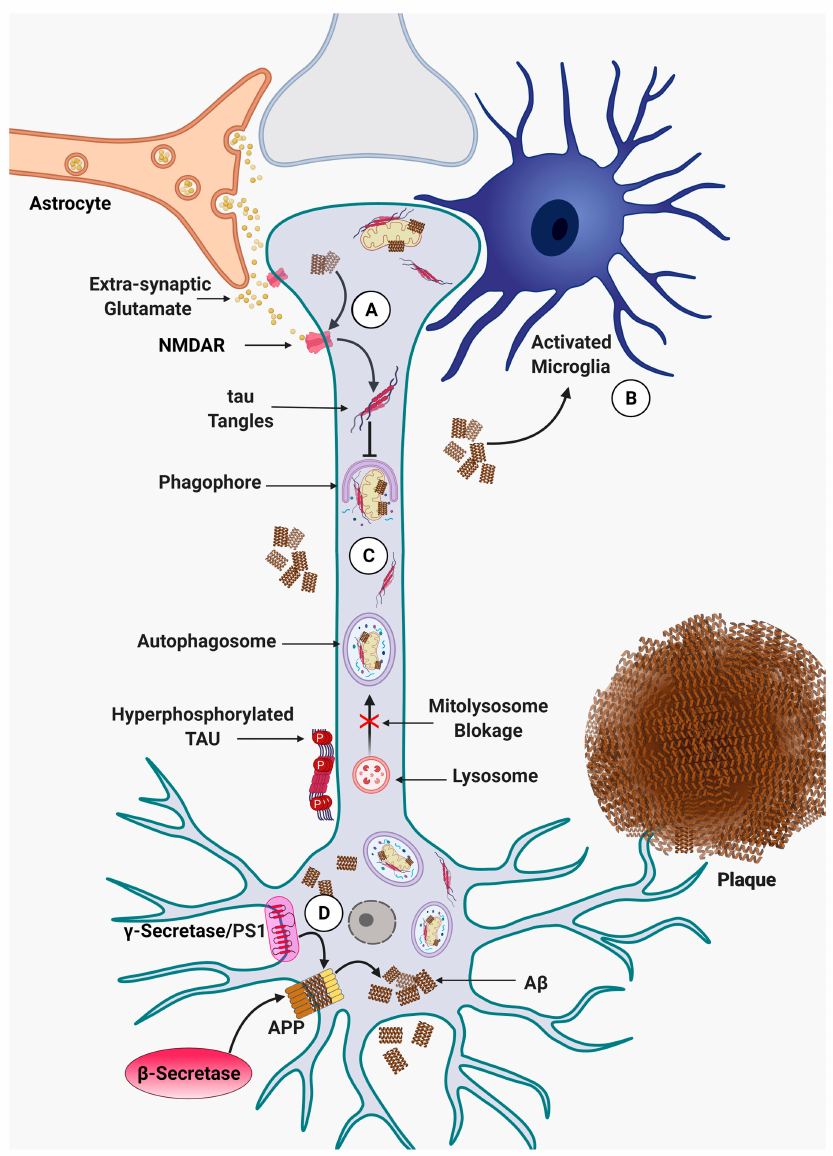
Figure 3. Mitophagy and microglia activation in Alzheimer disease. ( A ) Increased release of extra- synaptic glutamate from astrocytes, which results in extra-synaptic N-methyl-D-aspartate (NMDA) receptors activation, accompanied by the interference of A β oligomers with those receptors and inhi- bition of pro-survival pathways, triggering the pro-apoptotic signaling pathway. This phenomenon leads to dendritic spine loss and postsynaptic depression. ( B ) Microglia activation, which is induced by A β oligomers, proceeds inflammation and neurodegeneration via interference with immunolog- ical processes in the brain. ( C ) Impaired mitophagy represented as phagophore and mitolysosme blockage is promoted by p-tau, which leads to an energy production decline and increased oxidative stress, ( D ), which causes APP processing by β secretase and γ secretase/PS1. Accumulation of A β and P-Tau participate in mitophagy impairment, which initiates a vicious